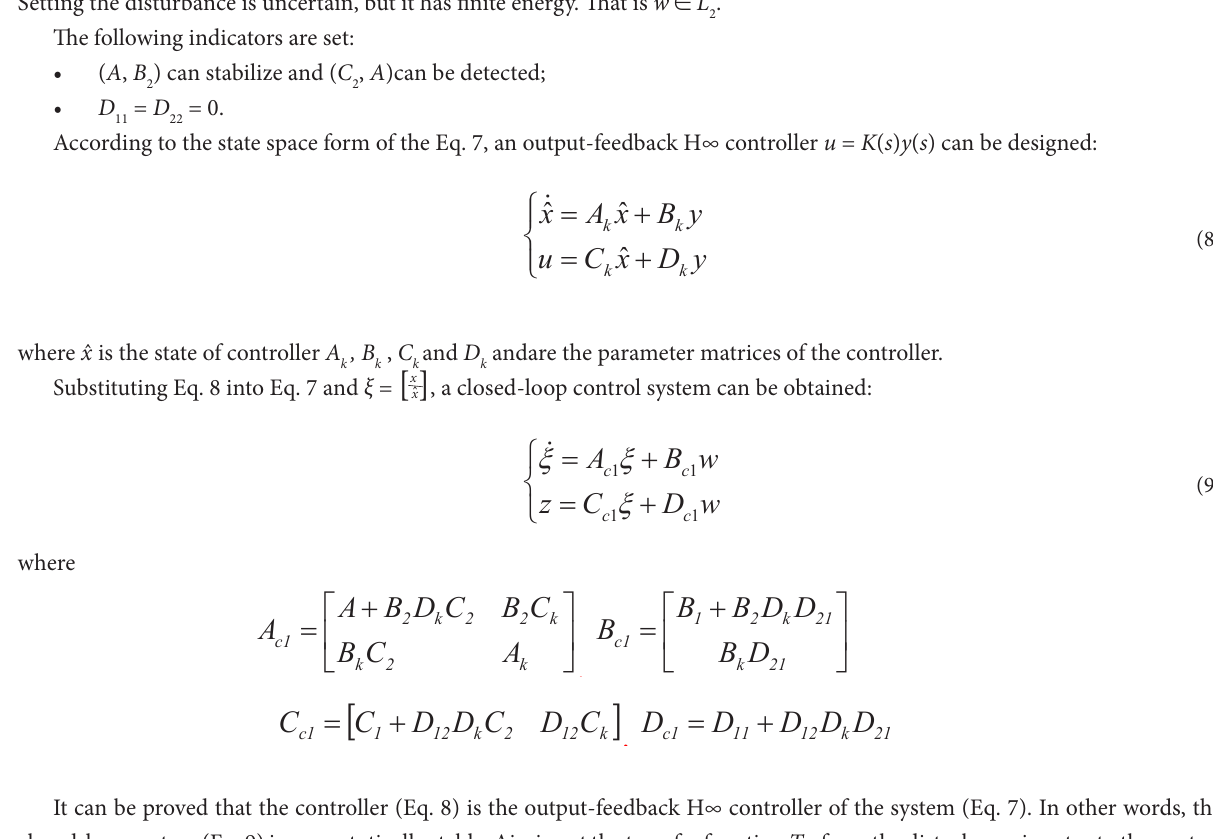
where w is the disturbing